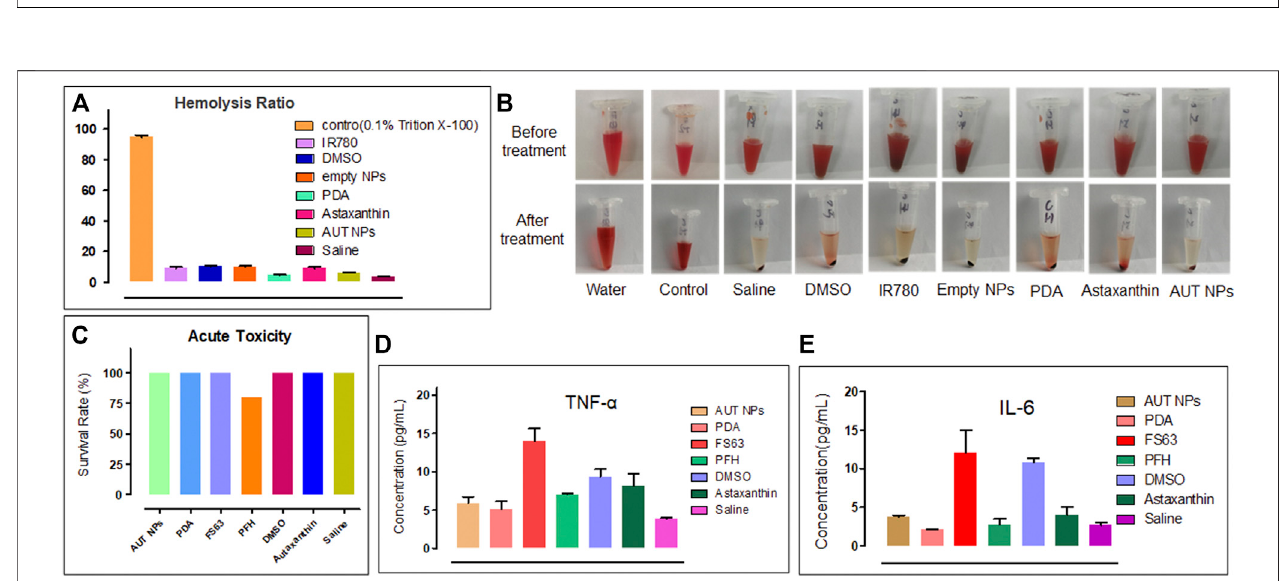
FIGURE6| Invivo toxicitytest ofAUT NPs.Theresults (A) and photographs (B) ofthehemolysis experiment. Theresults ofacute toxicity testofAUTNPs (C) .The TNF- α (D) and IL-6 (E) in fl ammatory markers detection results of AUT NPs and the other control materials.